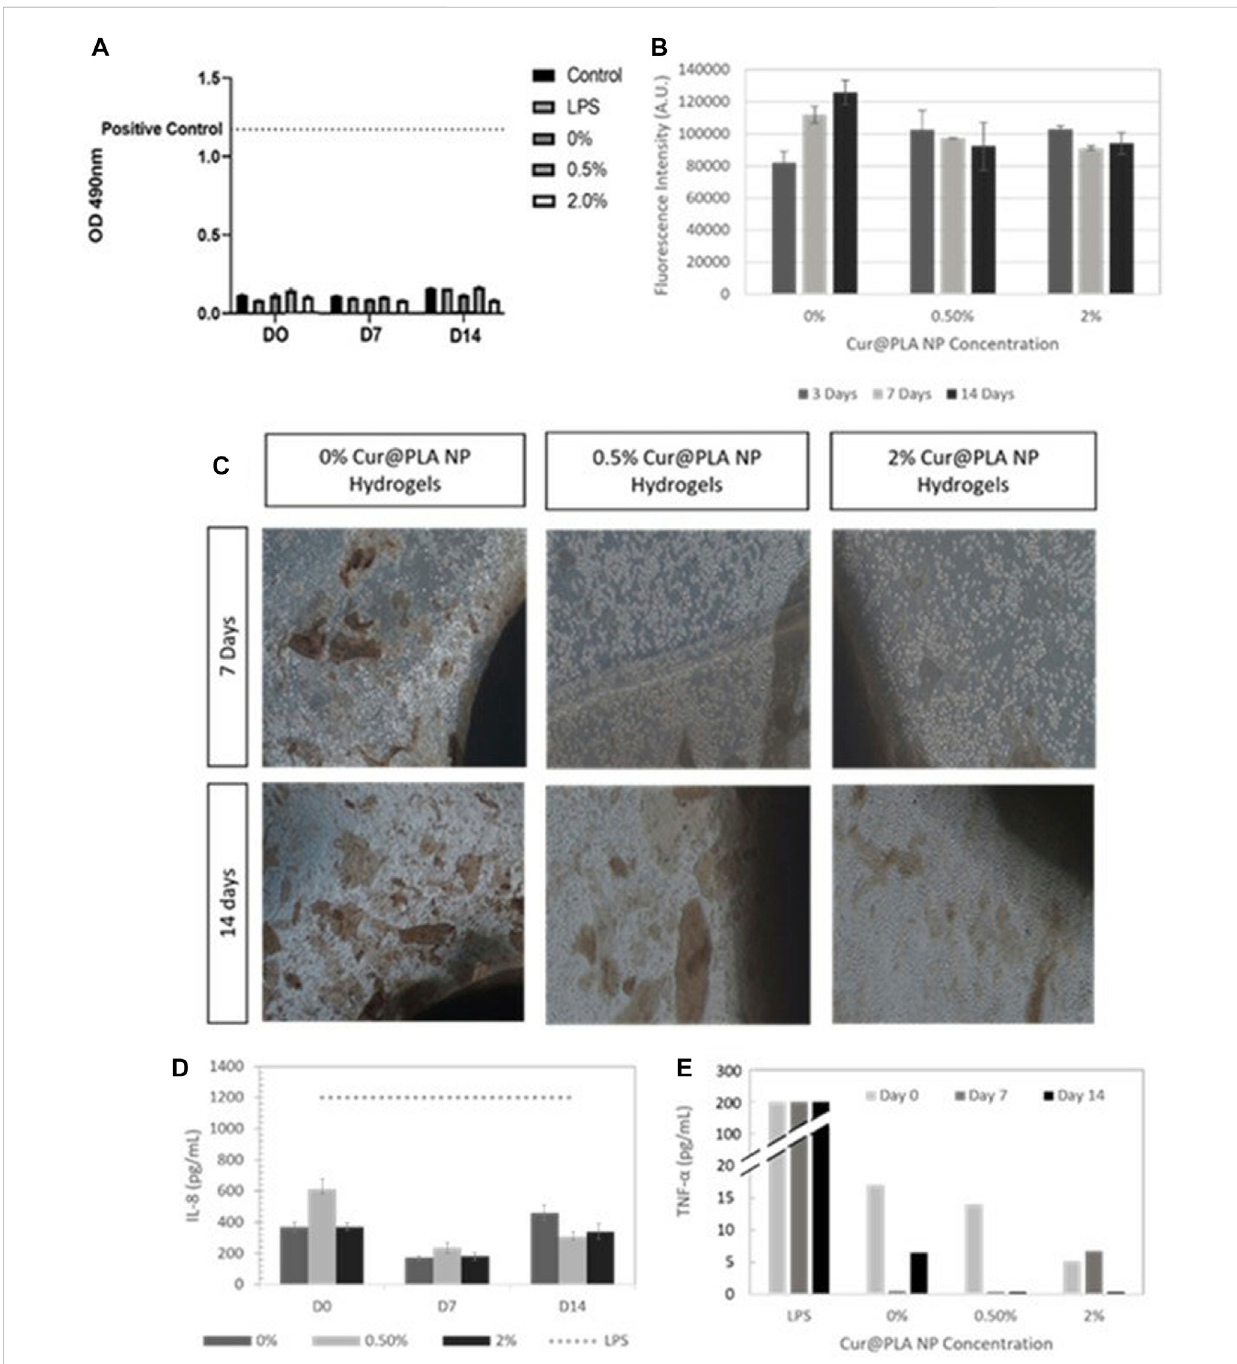
FIGURE 6 AnevaluationofcytocompatibilityofhydrogelscontainingdifferentconcentrationsofcurcuminbyLDH (A) andAlamarblue (B) .Opticalmicroscope images of hydrogel cultured cells containing different concentrations of curcumin at 7 and 14 days (C) . The levels of IL-8 (D) and TNF- α (E) produced by cells when exposed to hydrogels with different concentrations of curcumin. Reproduced with permission from a previous publication (Zamboni et al.,